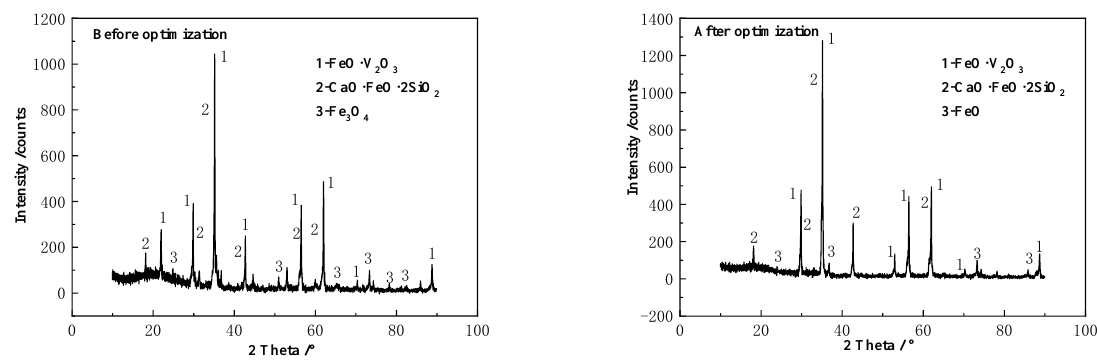
Figure 9. XRD measurement of vanadium slag before and after process optimization.